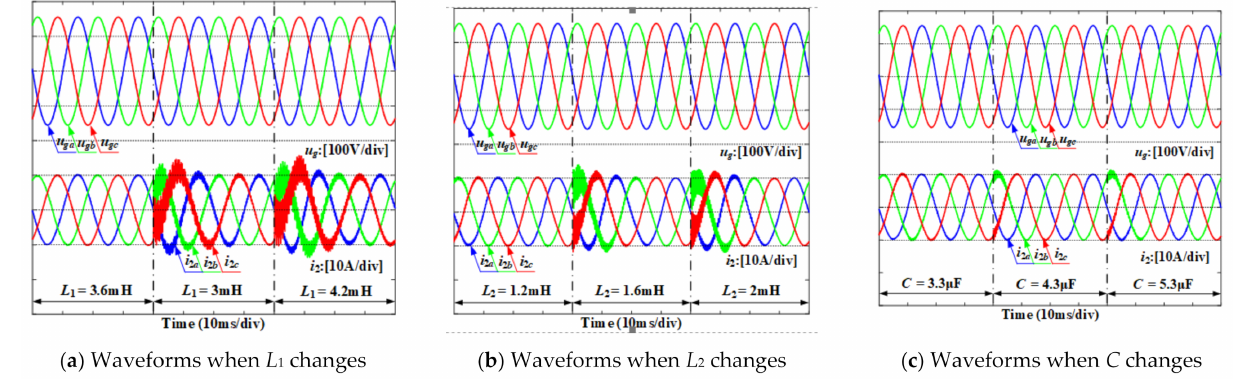
Figure 14. Simulation waveforms for PCS with LCL parameter